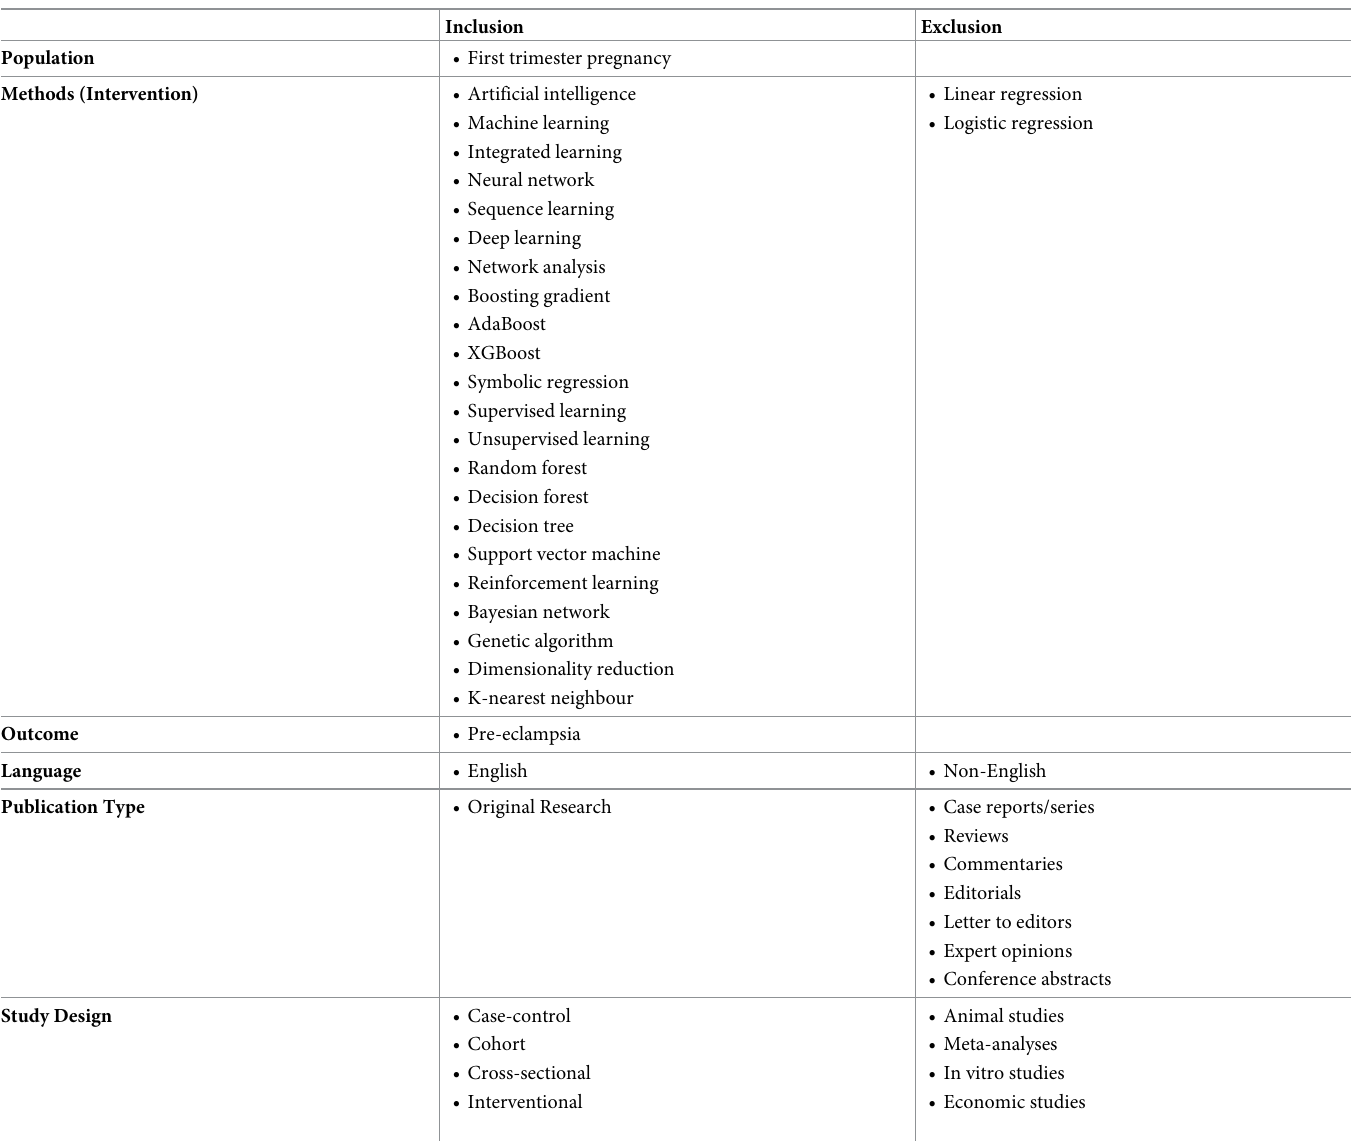
Table 1. Inclusion/exclusion criteria.